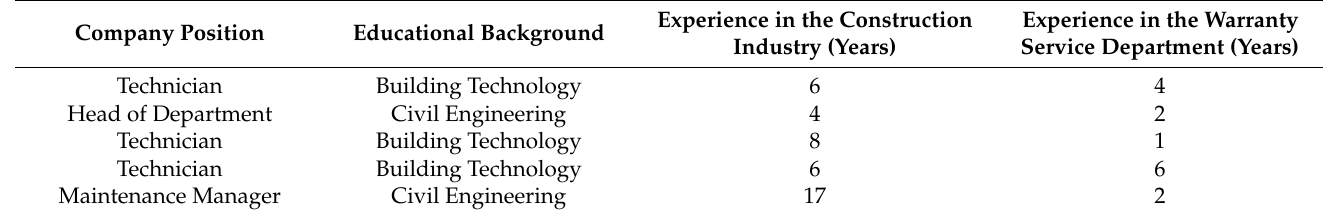
Table 1. Warranty service team profile.